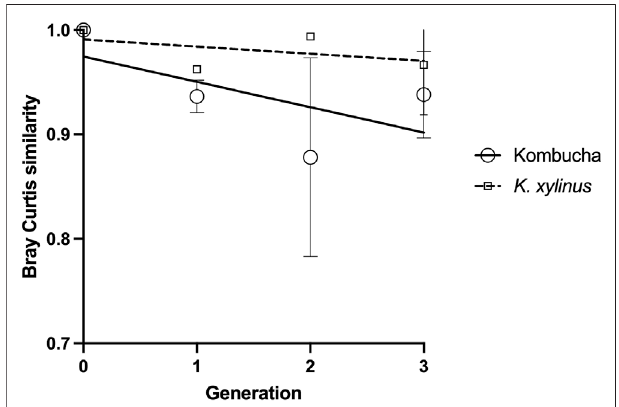
FIGURE 6 | Trend of changes in the pellicle bacterial community relative to the original inoculant using the Bray – Curtis index.